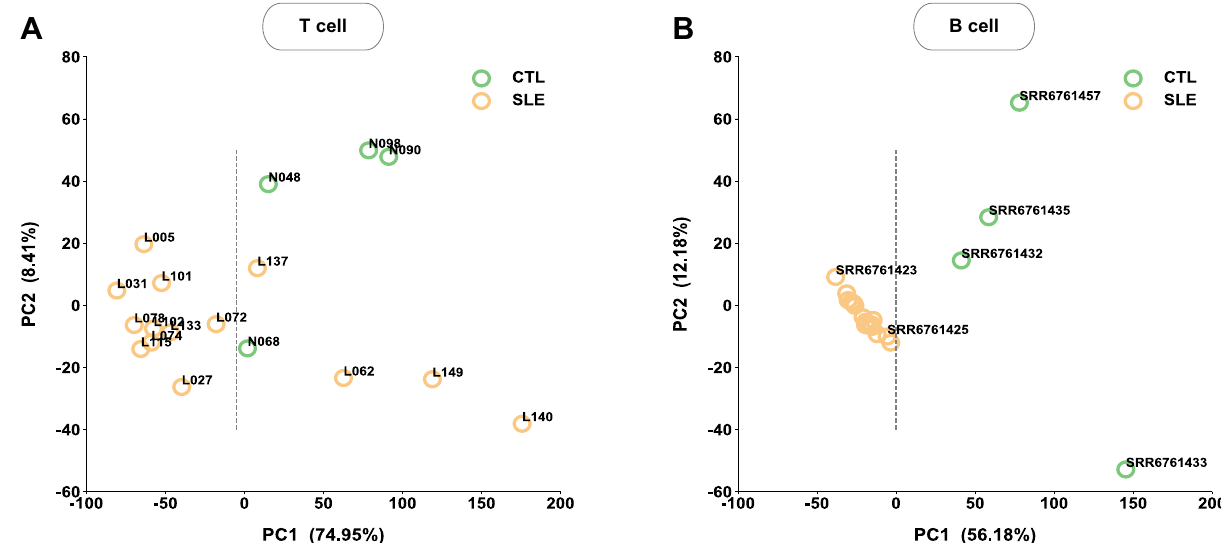
Figure 3. Principal component analysis (PCA) on IRI for T-cell and B-cell samples. ( A ) The 18 T-cell samples were projected onto the top two components (PC1 and PC2) with PC1 covering 74.49% of sample variation and PC2 8.41%. Samples projected onto positive or negative directions of PC1 were delineated by a vertical dashed line. ( B ) Similar results for the 20 B-cell samples where PC1 explained 56.18% of sample variation and PC2 12.18%. The projection onto the positive and the negative directions along PC1 separated, respectively, the control samples (CTL, green) from either the majority SLE samples (SLE, gold) for T cells or all the SLE samples (SLE, gold) for B